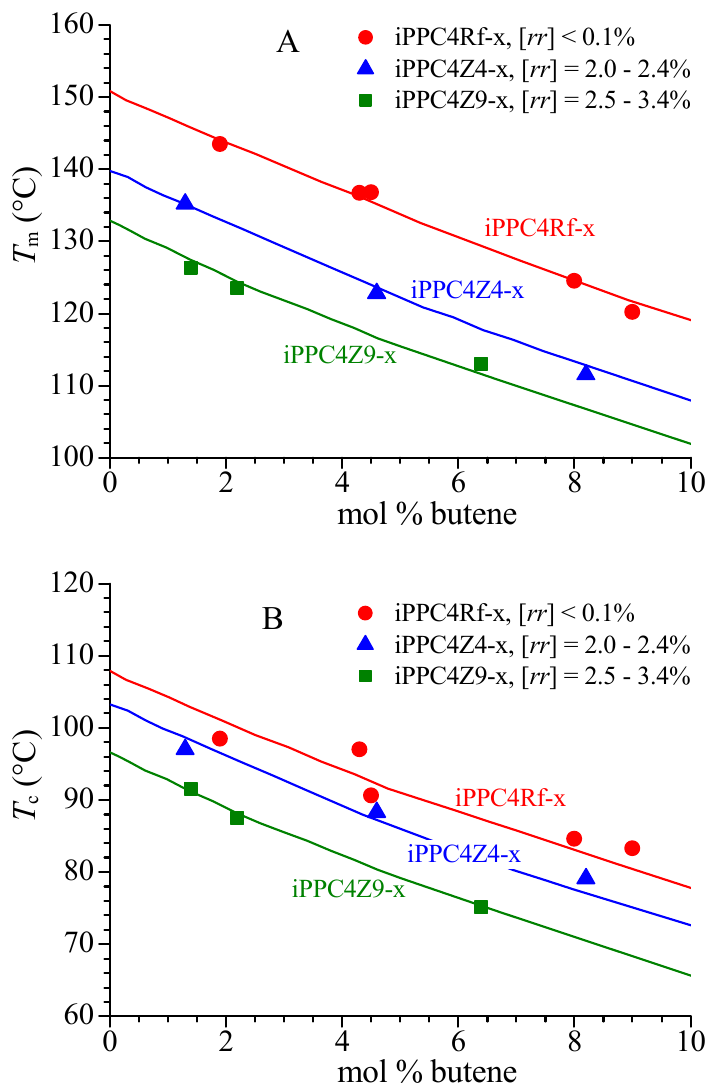
Figure 4. Melting temperature of the as-prepared samples ( A ) and crystallization temperature from the melt ( B ) of iPPC4 copolymers as a function of butene concentration evaluated from DSC thermograms recorded at scanning rates of 10 °C/min. Isotactic samples iPPC4Rf-x with [ rr ] < 0.1 mol% ( ) and less isotactic samples iPPC4Z4-x with [ rr ] = 2.0–2.4 mol% ( ) and iPPC4Z9-x with [ rr ] = 2.5–3.4 mol% ( ).